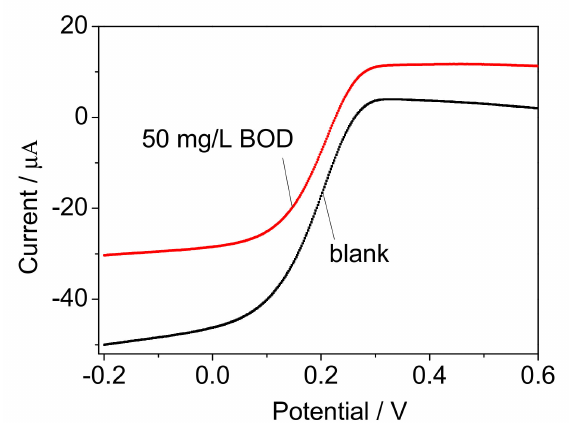
Figure 8. Linear sweep voltammetry (LSV) curves recorded at the interdigited ultramicroelectrode array (IUDA) for 50 mg/L BOD and blank solution after 15 min incubation with the rGO-PPy- B microbial biofilm in a bioreactor (both the 50 mg/L BOD solution and blank solution have 20 mM ferricyanide). Scan rate: 50 mV/s; each curve was the average of three replicate